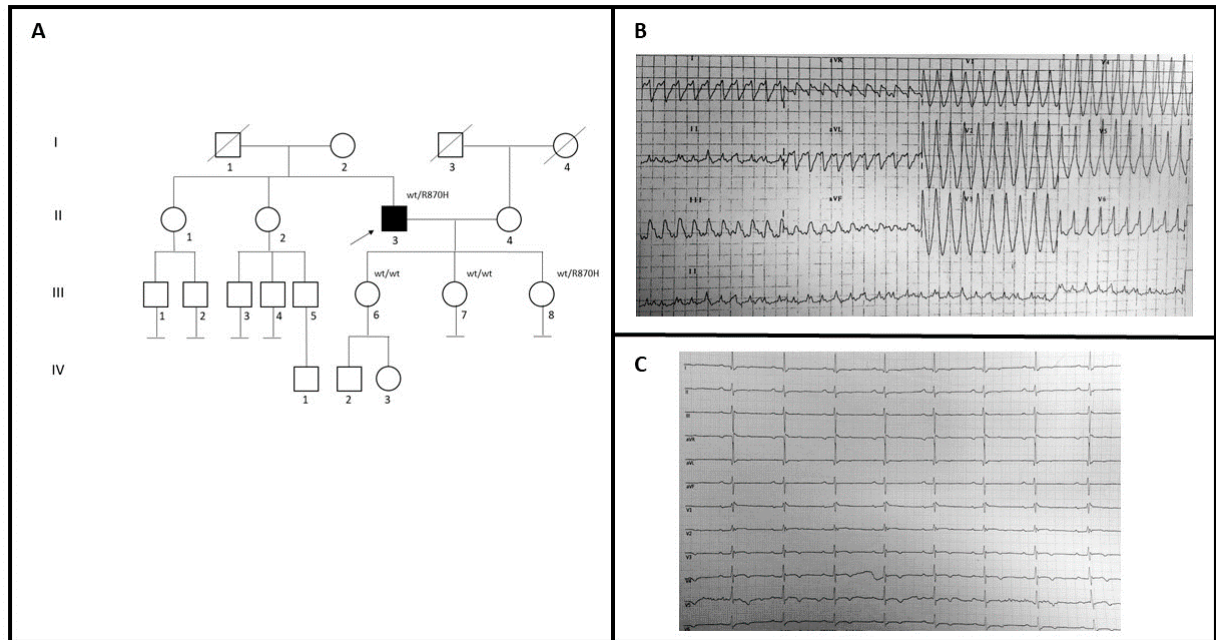
Figure 2. ( A ) Pedigree structure of family B, arrow indicates the proband affected (II-3); R870H is the variant identified within the MYH7 gene; ( B ) 12-lead ECG showing a wide QRS complex tachycardia; ( C ) basal ECG of the proband.